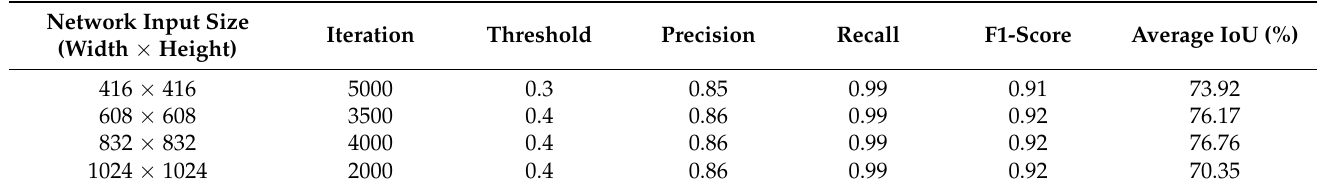
Table 7. The best model for each network input size on YOLOv4 is based on training and validation.